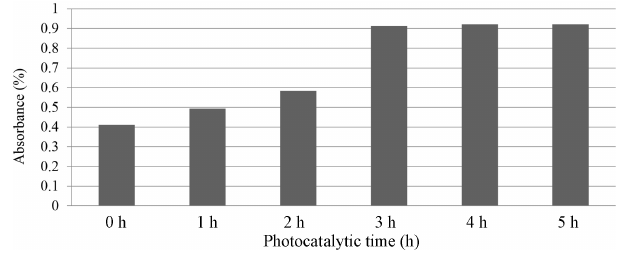
Figure 2. The photocatalytic time vs. absorbance without SL.